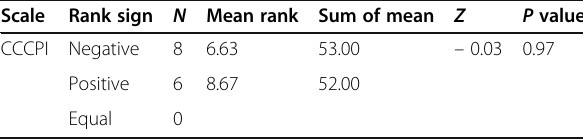
Table 7 Findings obtained from the pre- and post-test Wilcoxon signed-ranks test for the control